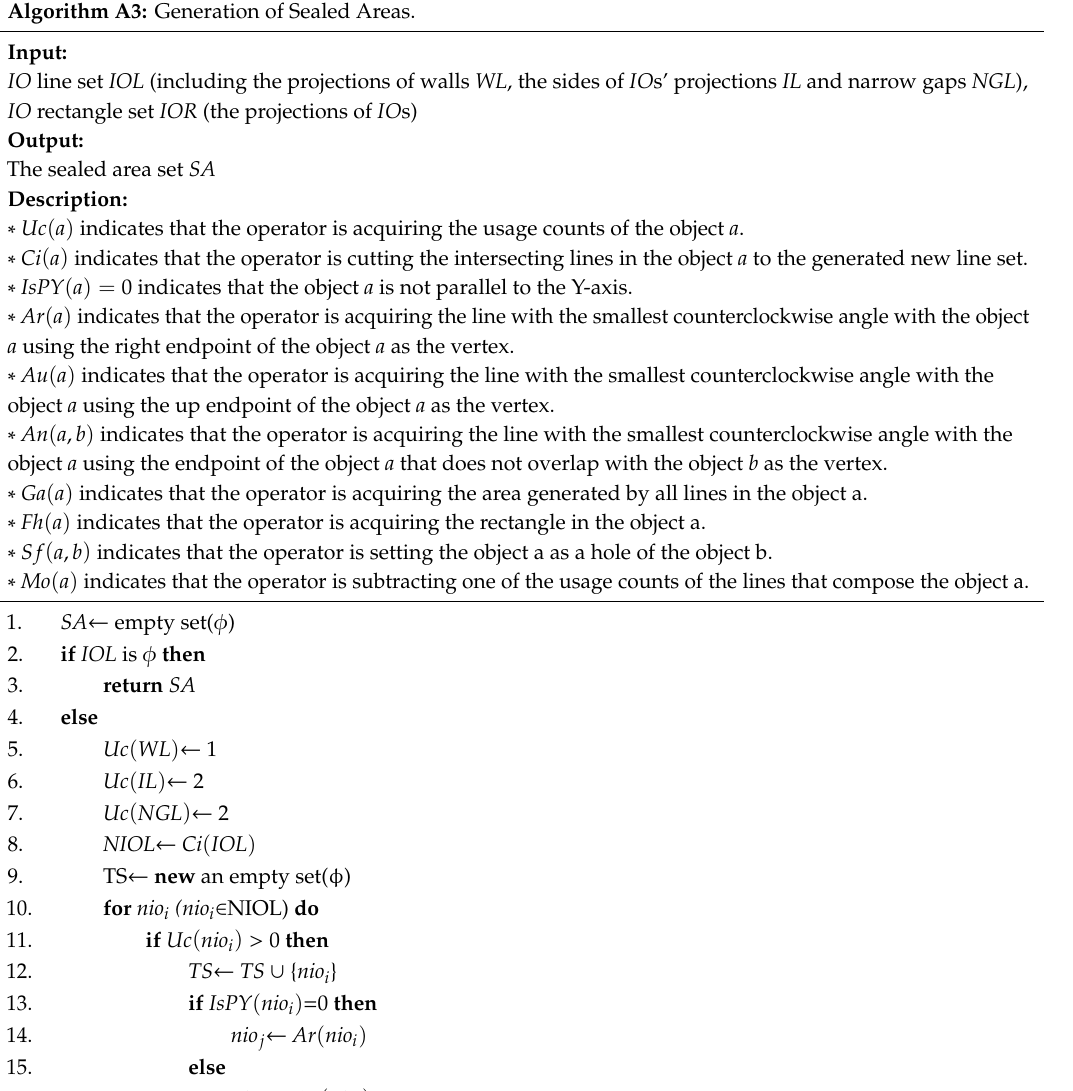
Algorithm A3: Generation of Sealed